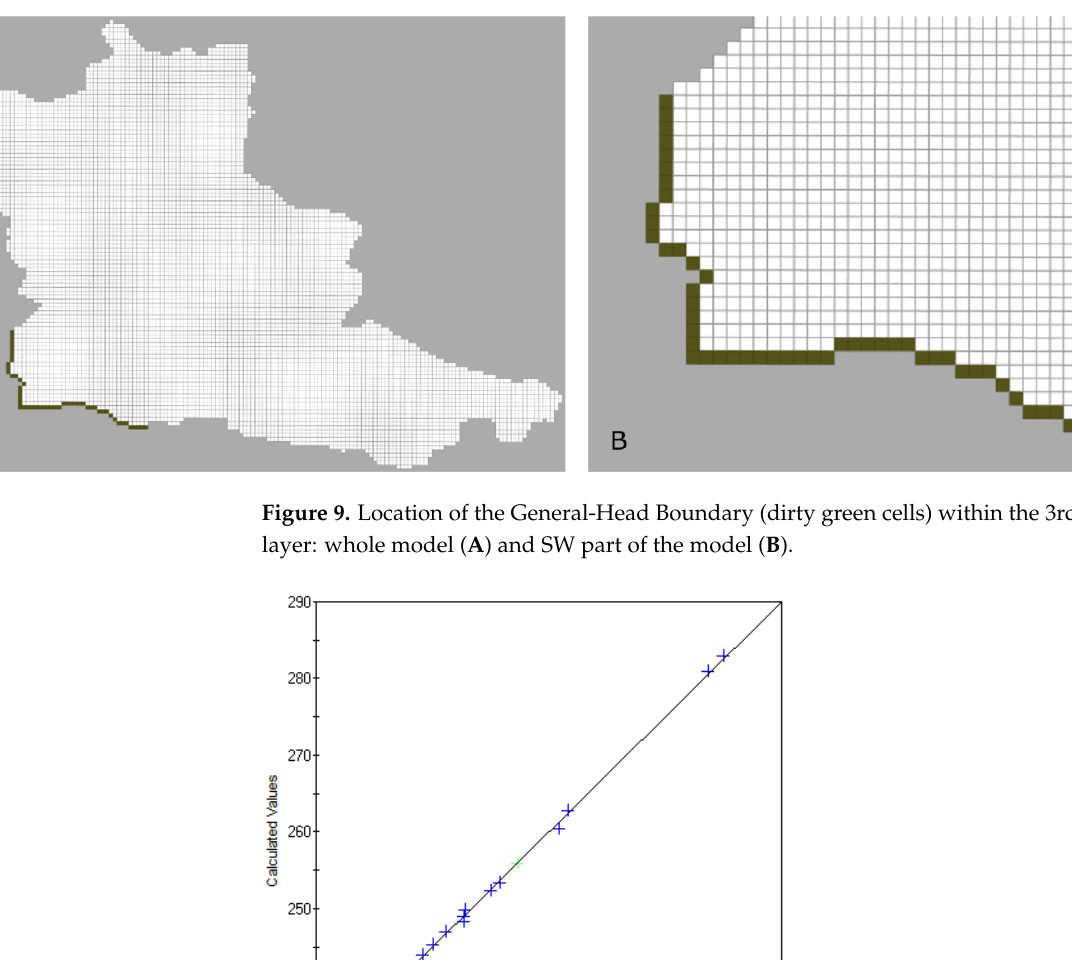
Figure 9. Location of the General-Head Boundary (dirty green cells) within the 3rd, 4th, 5th and 6th layer: whole model ( A ) and SW part of the model ( B ).